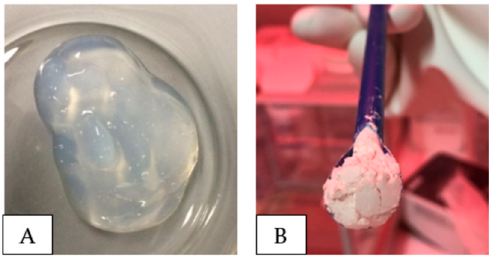
Figure 4. Pictures of nanocellulose stock dispersion ( A ) CNC (USDA) and ( B ) CNC (AITF).